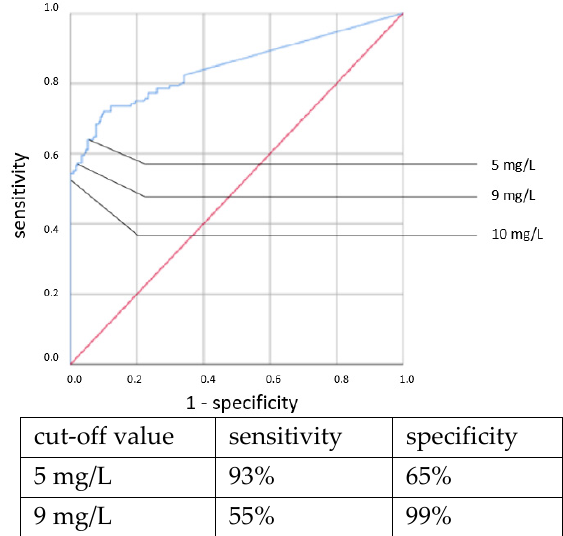
Figure 6. CRP concentration at the time of sepsis workup. Clinical EOS.